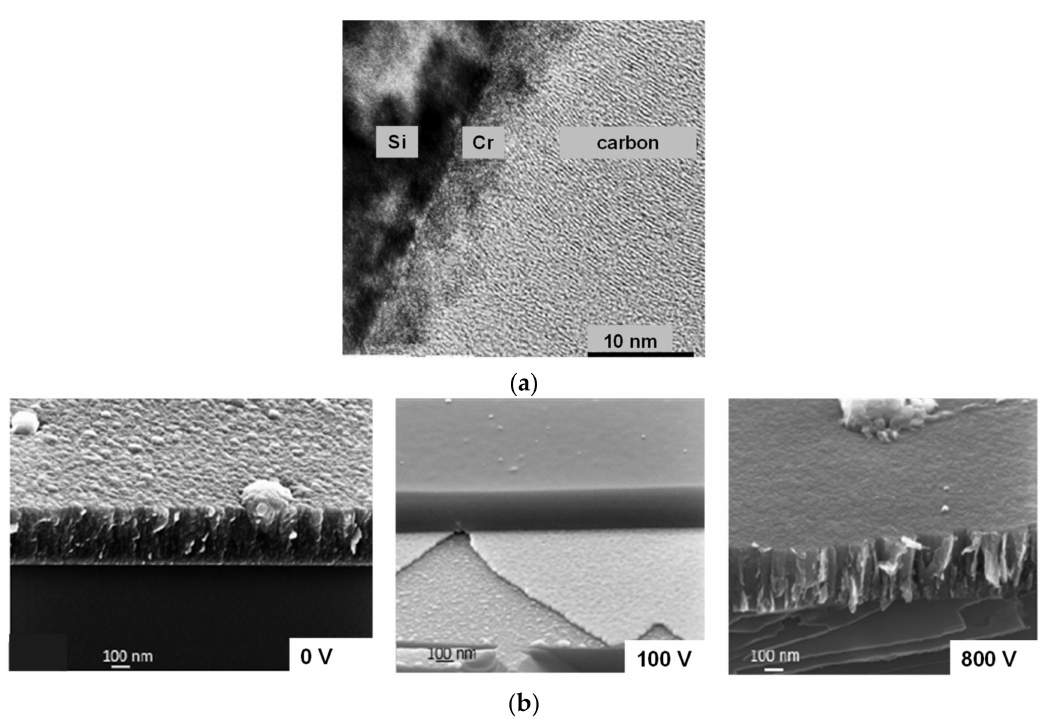
Figure 15. Carbon films, deposited by filtered anodic Laser-Arc (1.6 kA, 300 Hz) [74]. ( a ) Cross section, bias voltage 800 V (TEM image). ( b ) Cross section, bias voltage 0, 100, and 800 V (SEM